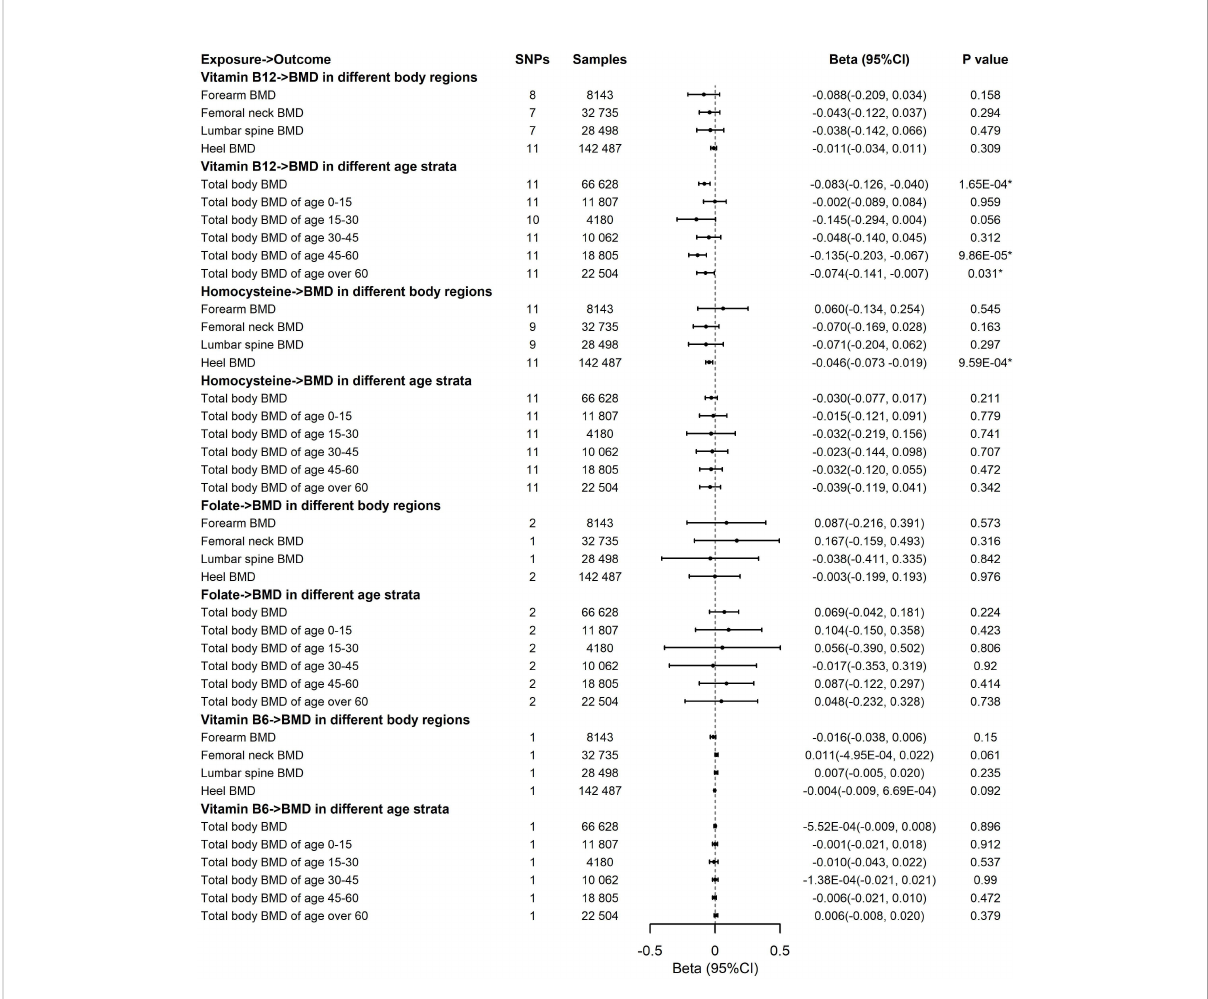
FIGURE 4 Effects of the genetic prediction of circulating vitamin B12, homocysteine, folate, and vitamin B6 on bone mineral density in different body regions and different age strata with the inverse variance weighting method. BMD, body mineral density; CI, con fi dence interval; GEFOS, GEnetic Factors for OSteoporosis Consortium; IVW, inverse variance weighting; The summary statistics data utilized in this study can be downloaded from the GWAS Catalog (https://www.ebi.ac.uk/gwas/) and Neale Lab (http://www.nealelab.is/uk-biobank); *The P-value reached the signi fi cant level; SNP, single-nucleotide